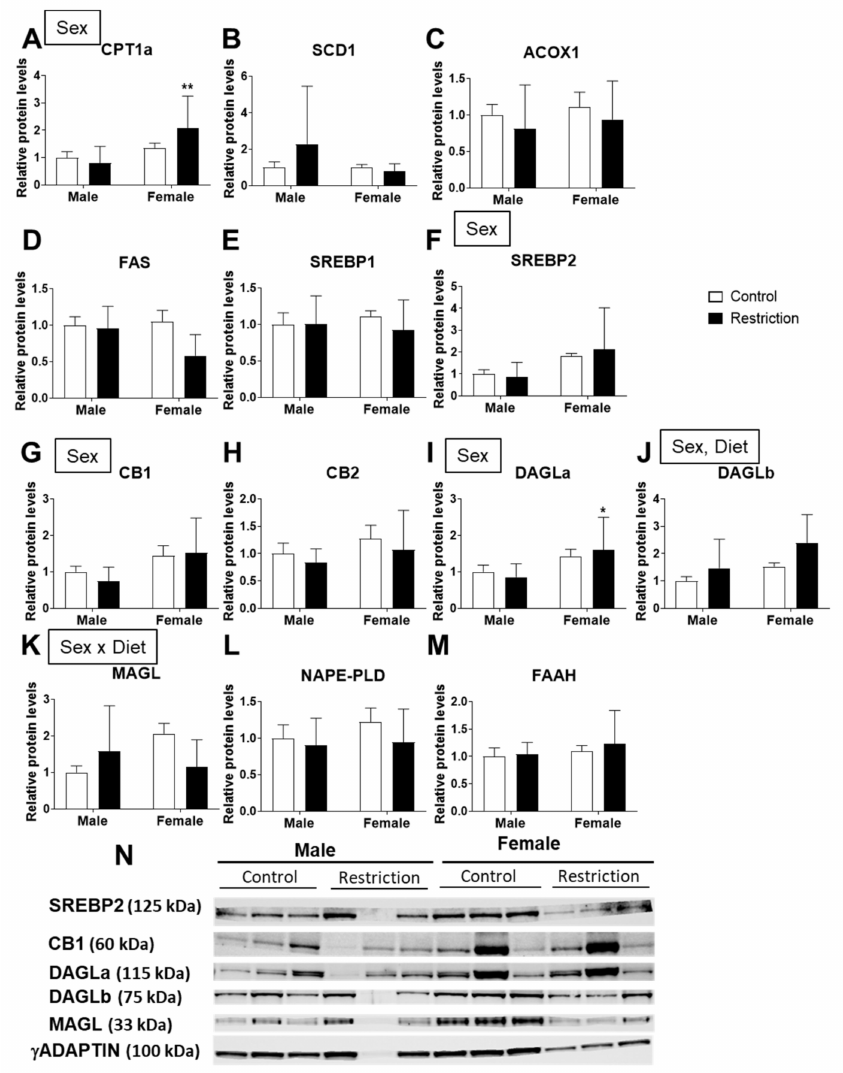
Figure 6. Effect of maternal caloric restriction on protein levels of principal genes of lipid metabolism: CPT1a ( A ), SCD1 ( B ), ACOX1 ( C ), FAS ( D ), SREBP1 ( E ) and SREBP2 ( F ); and the endocannabinoid system: CB1 ( G ), CB2 ( H ), DAGLa ( I ), DAGLb ( J ), MAGL ( K ), NAPE-PLD ( L ) and FAAH ( M ) in hypothalamic astrocytes of male and female pups at PND2. Representative membranes of the main changes ( N ). Data are expressed as the mean ± S.E.M. (control male: n = 10; restriction male: n = 14; control female: n = 9; restriction female: n = 10). Tukey or single-effect analysis: */** p < 0.05/0.01 vs. males (sex difference). The main results of the two-way ANOVA (effect of sex, diet and/or sex × diet interaction) are indicated above the